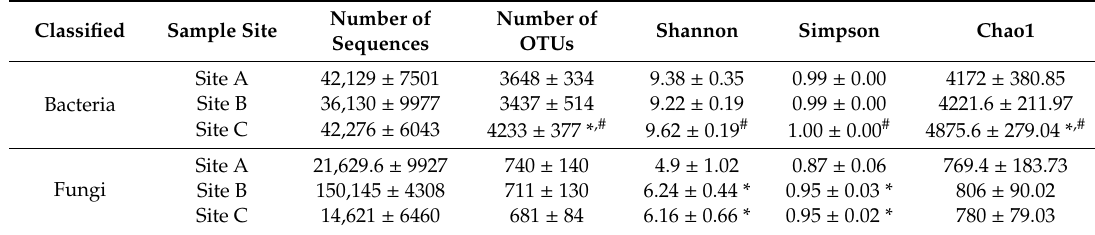
Table 3. Diversity indices of soil microbial communities based on 16S rRNA and internal transcribed spacer (ITS)